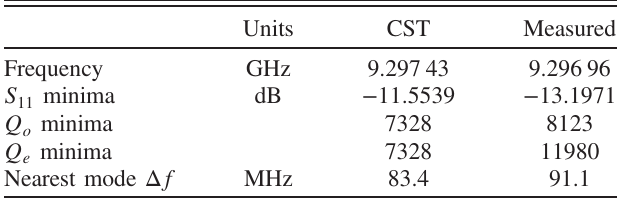
TABLE III. S11 measurement of the operating mode.